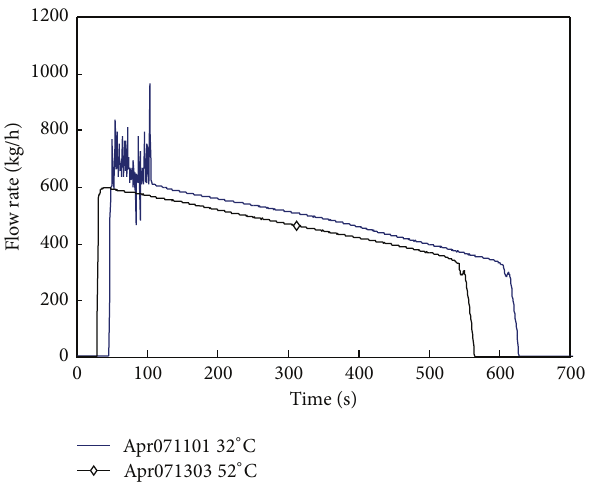
Figure 7: Water hammer influenced by feedwater temperature.